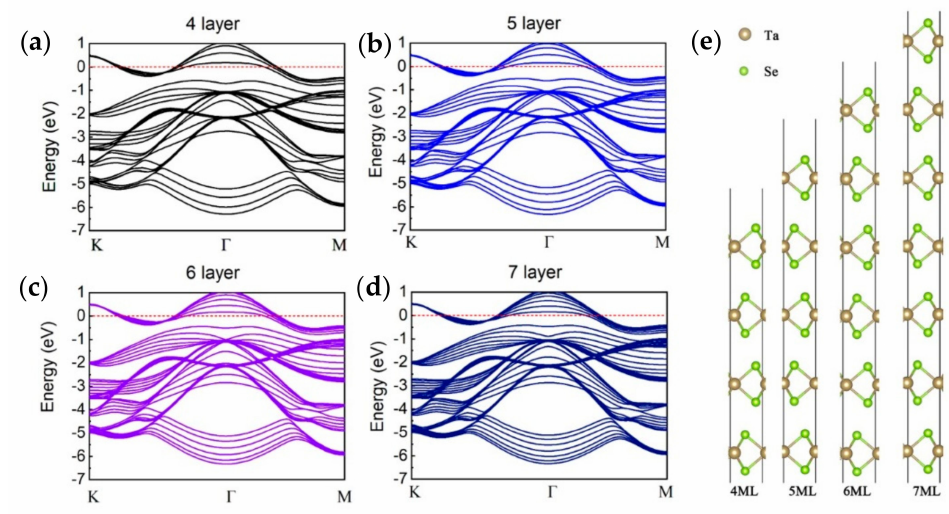
Figure 2. Band structures for multilayer TaSe 2 : ( a ) four-, ( b ) five-, ( c ) six-, and ( d ) seven-layer TaSe 2 ; ( e ) corresponding atomic-layered structures of TaSe 2 .